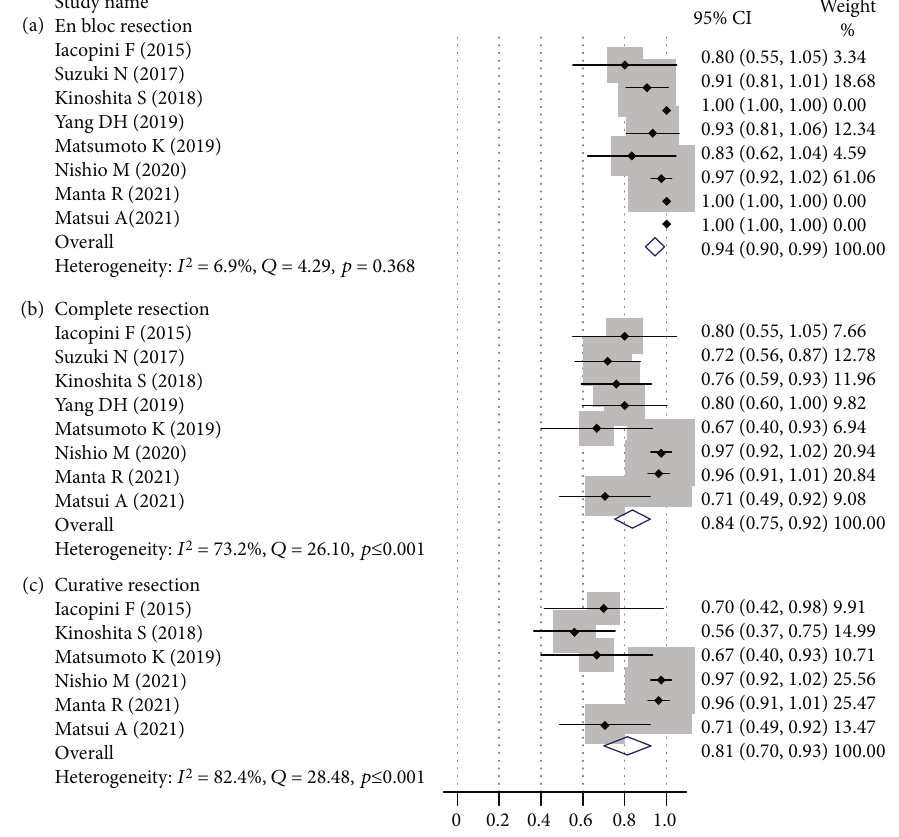
Figure 2: Resection rates and pooled estimates of endoscopic submucosal